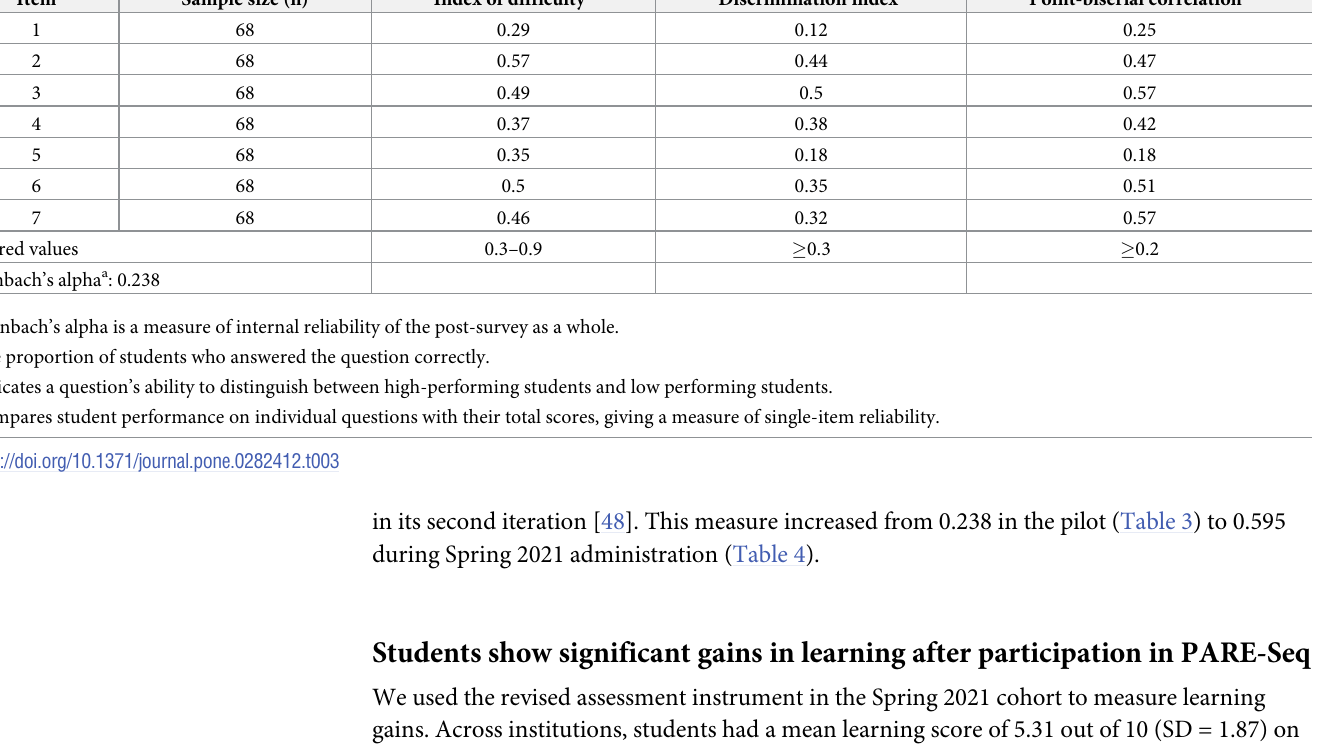
Table 3. Fall 2020 pilot item analyses: Difficulty, reliability, and discriminatory power of the student post-survey. Item Sample size (n)